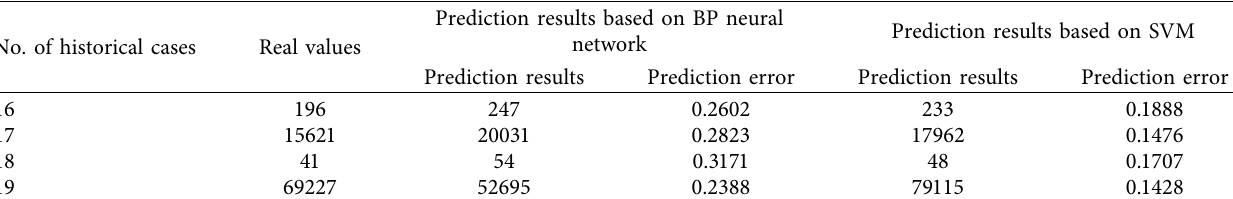
Figure 9: Prediction results of the two methods. (a) Prediction results based on the BP neural network and (b) prediction results based on SVM. Table 10: Comparison of prediction results based on BP neural network and SVM.